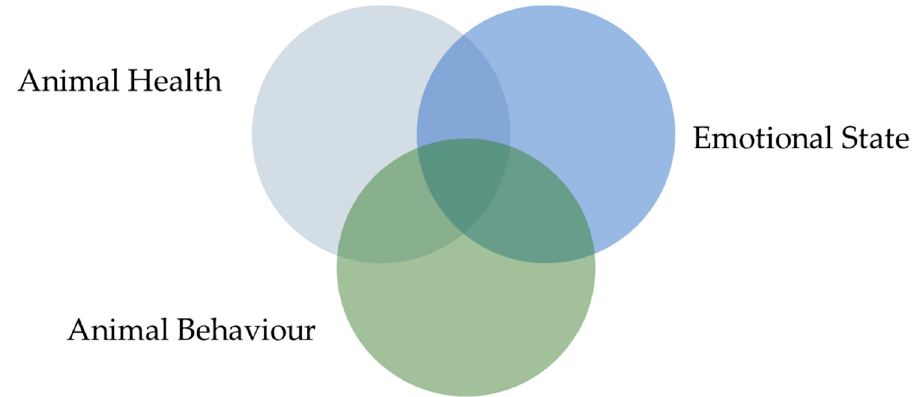
Figure 1. Fraser’s multi-dimensional animal welfare model ([15] modified).